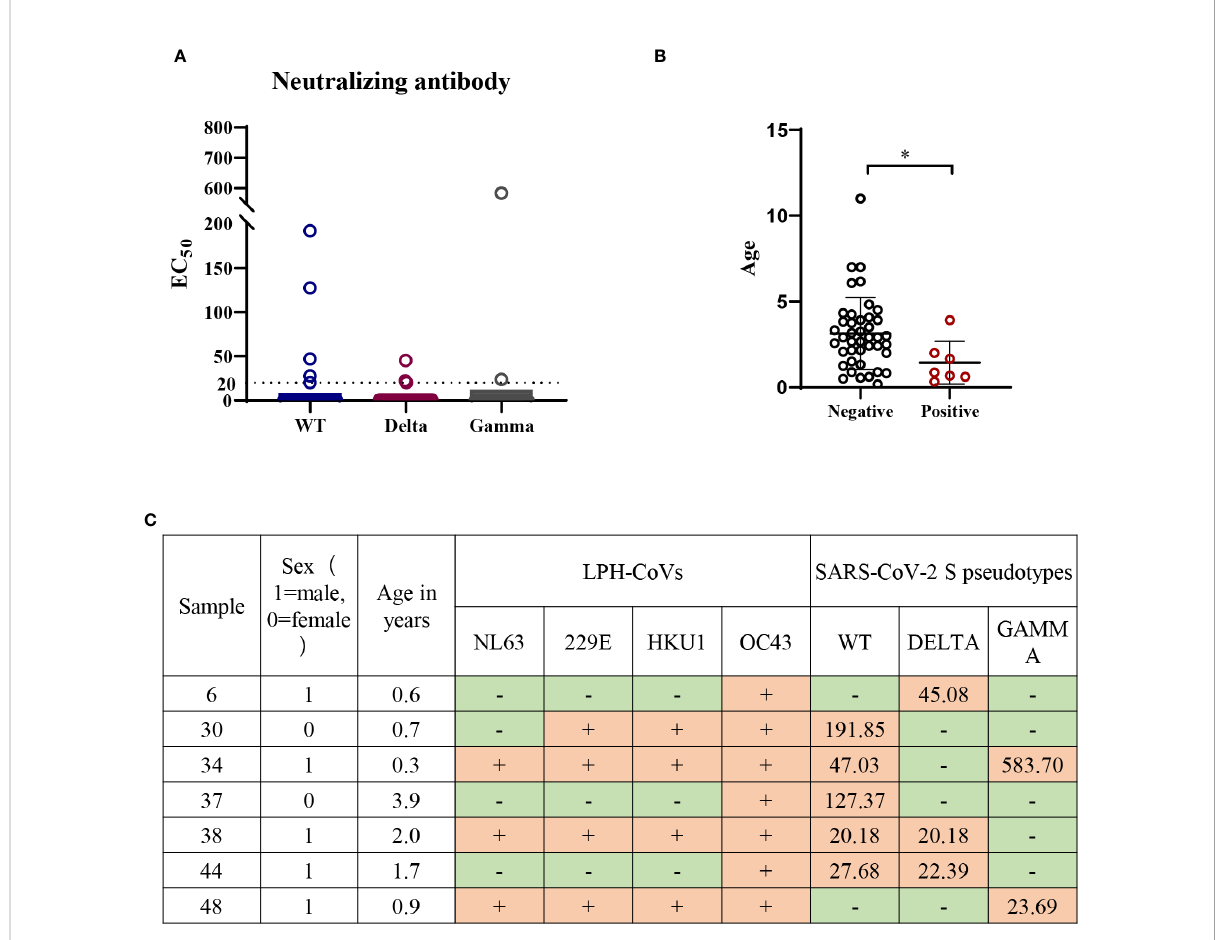
FIGURE 7 Low or undetectable neutralizing antibodies against WT or mutant SARS-CoV-2 S pseudotypes were found in the individuals with cross-reactive S-speci fi c IgG antibodies against SARS-CoV-2 (A) The measurement of neutralization activity for the forty-nine serum samples with S-speci fi c antibodies against SARS-CoV-2 via SARS-CoV-2 S pseudotypes neutralization assay. The dashed line represents a threshold set (EC 50 >20). (B) The age range for the serum samples with neutralizing antibodies against SARS-CoV-2 or variants. A two-tailed P value <0.05 was considered to be statistically signi fi cant, (* P values of ≤ 0.05). (C) The list of serum samples with neutralizing antibodies against SARS-CoV-2 S